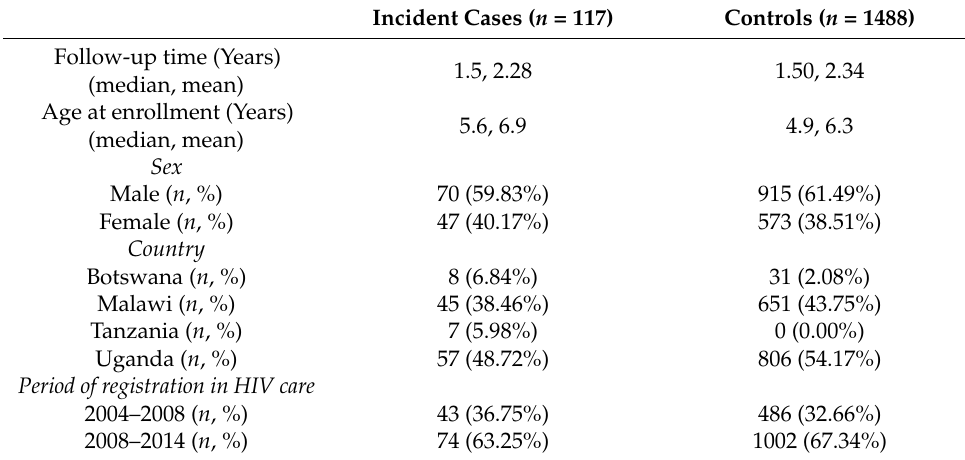
Table 1. Demographic characteristics of nested incident cases and